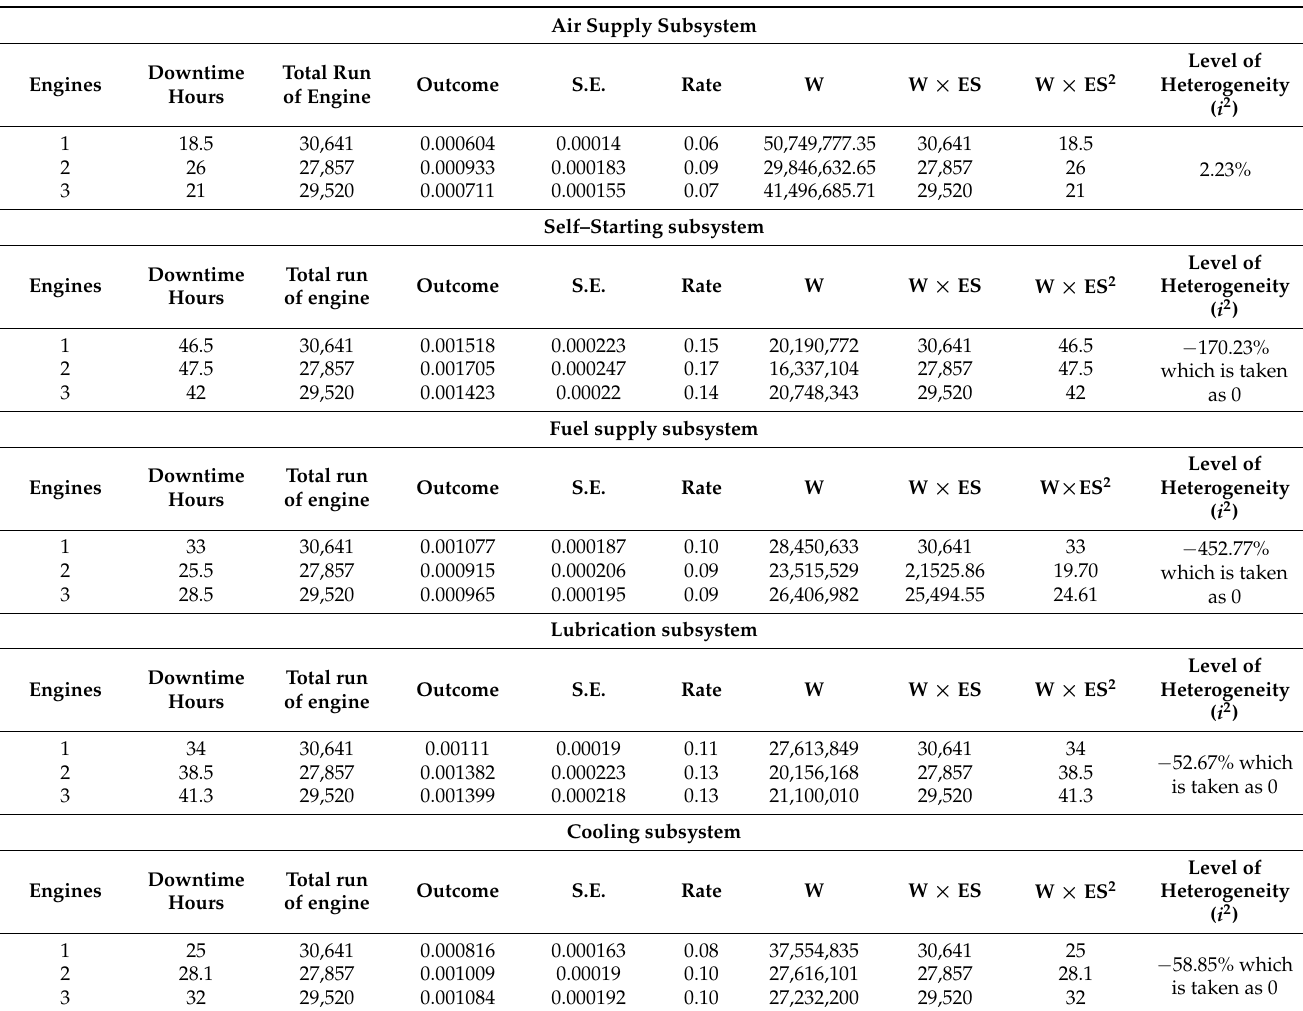
Table 5. Level of Heterogeneity ( i 2 ) values of all five